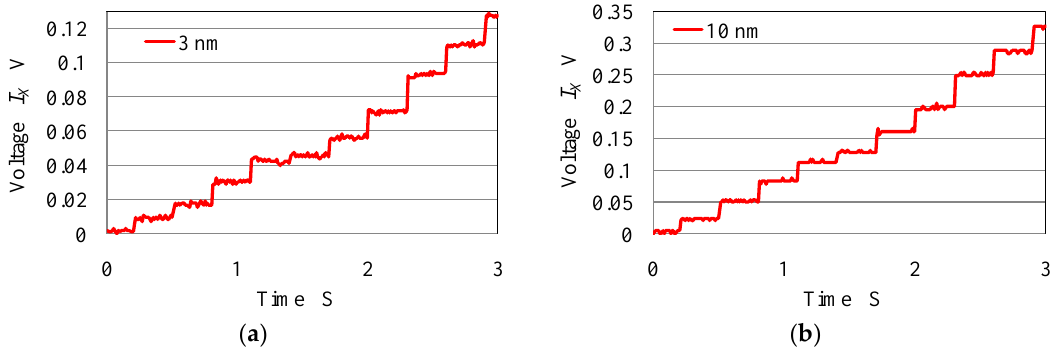
Figure 17. Output voltage I X induced by step feeding displacement. ( a ) 3 nm; and ( b ) 10 nm.